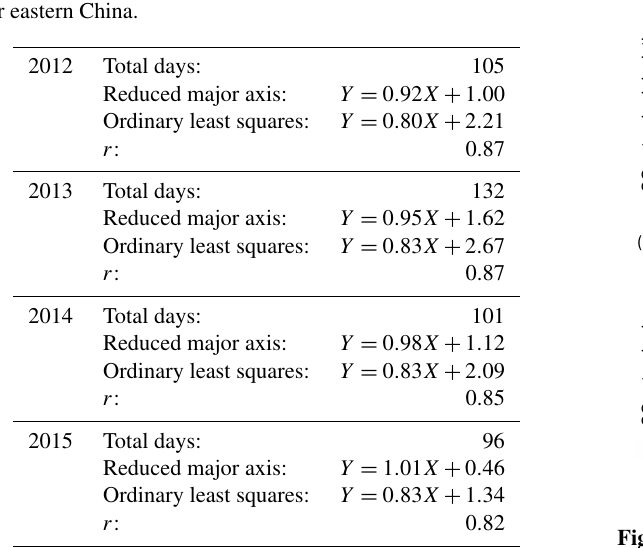
Figure 7. Standard deviation (SD, a ) and standard error (SE, b ) of SO 2 noise (DU) averaged over clean background regions in the Pacific (150–120 ◦ W), in the north between 30 and 42 ◦ N (Red), in the tropics between 10 ◦ S and 10 ◦ N (black), and in the south between 30 and 20 ◦ S (blue) in August of each year from 2005 to 2015. Solid lines are medians of daily SO 2 SD from each month (31 days), and dashed lines are 25 and 75% of daily SO 2 SD from each month, respectively. OMI data start in 2005 and OMPS data start in 2012. The OMI SD peak in 2008 over north Pacific results from the Okmok and Kasatochi eruptions (Krotkov et al.,